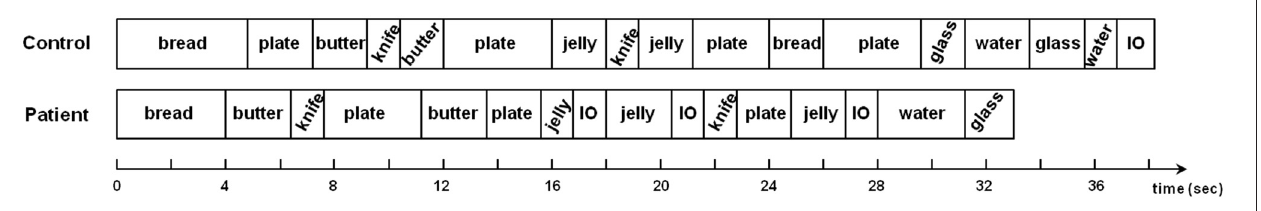
FIGURE 3 | Sequence of objects fixated to accomplish the task (active viewing) for one participant of each group. IO, irrelevant